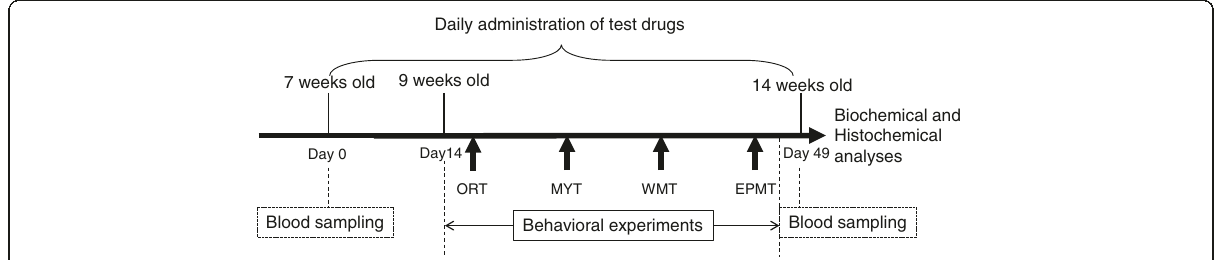
Figure 1 Schematic drawing of experimental schedule. After one week of acclimatization, the db/db mice were randomly divided into 5 groups. Age-matched m/m and db/db mice were used as controls in the behavioral and neurochemical